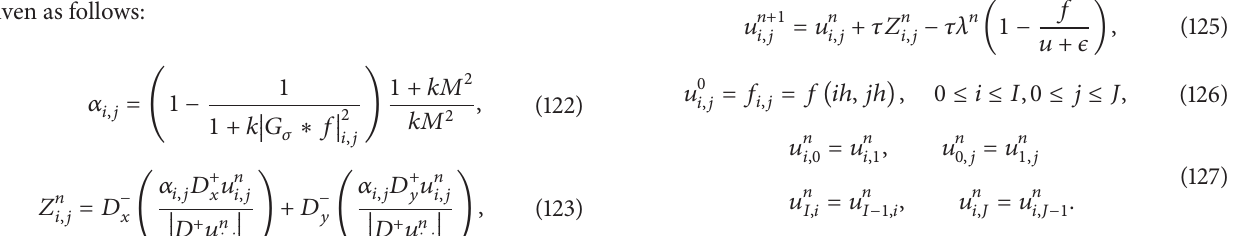
where 𝑚[𝑎, 𝑏] = ( sign 𝑎 + sign 𝑏) min (|𝑎|, |𝑏|)/2 and 𝜖 > 0 is the regularized parameter chosen near